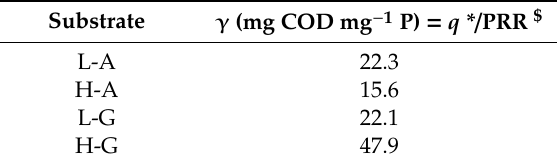
Table 6. The required chemical oxygen demand (COD) amount for phosphorous release.